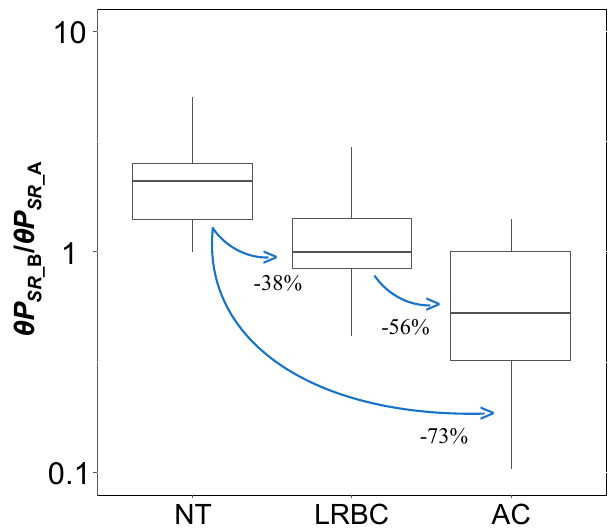
Figure 12. Reduction in rainfall threshold for the initiation of surface runoff. Rainfall threshold in plot B ( θ P SR _B ) was normalised by rainfall threshold in plot A ( θ P SR _A ).